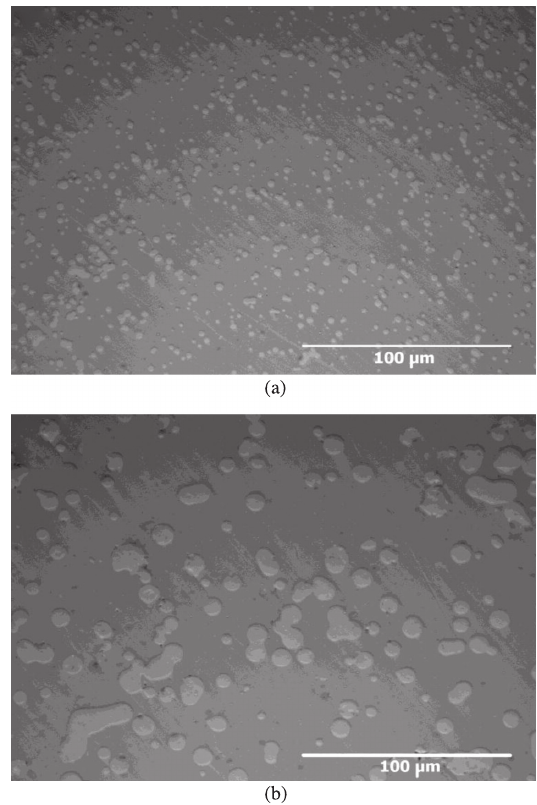
Figure 2. Micrographs of glass-ceramics obtained from Li Al Ge (PO ) glass heat-treated at 590 °C for 50 minutes 1.5 0.5 1.5 4 3 (a) and heat-treated at 610 °C for 20 minutes (b). The images were obtained by reflected-light optical